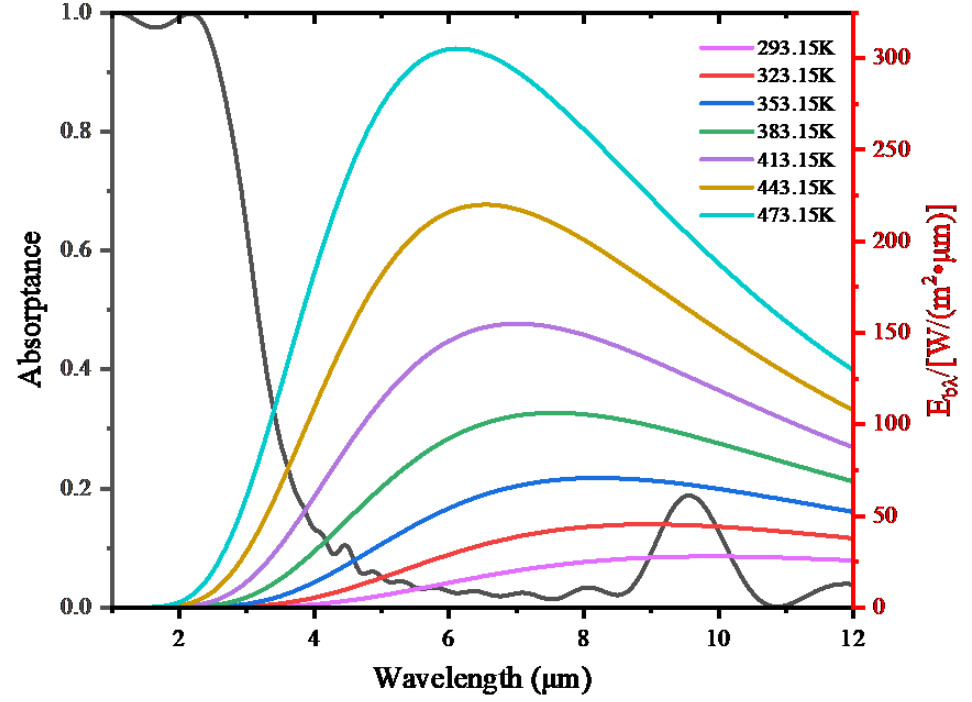
Figure 6. The absorption spectrum of the absorber in part of the infrared region and the spectral emissive power of a blackbody varies with